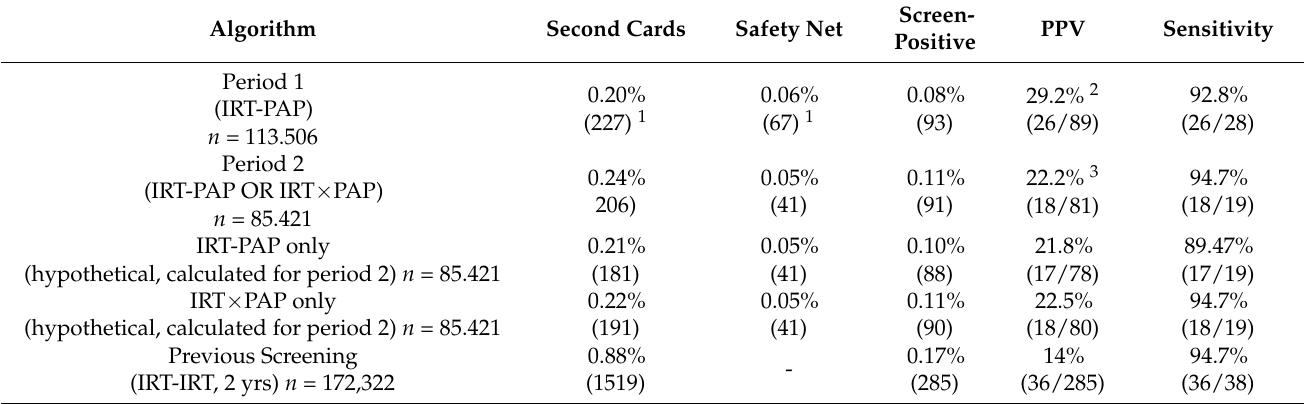
Table 2. Comparison of different CF screening algorithms in Austrian newborn